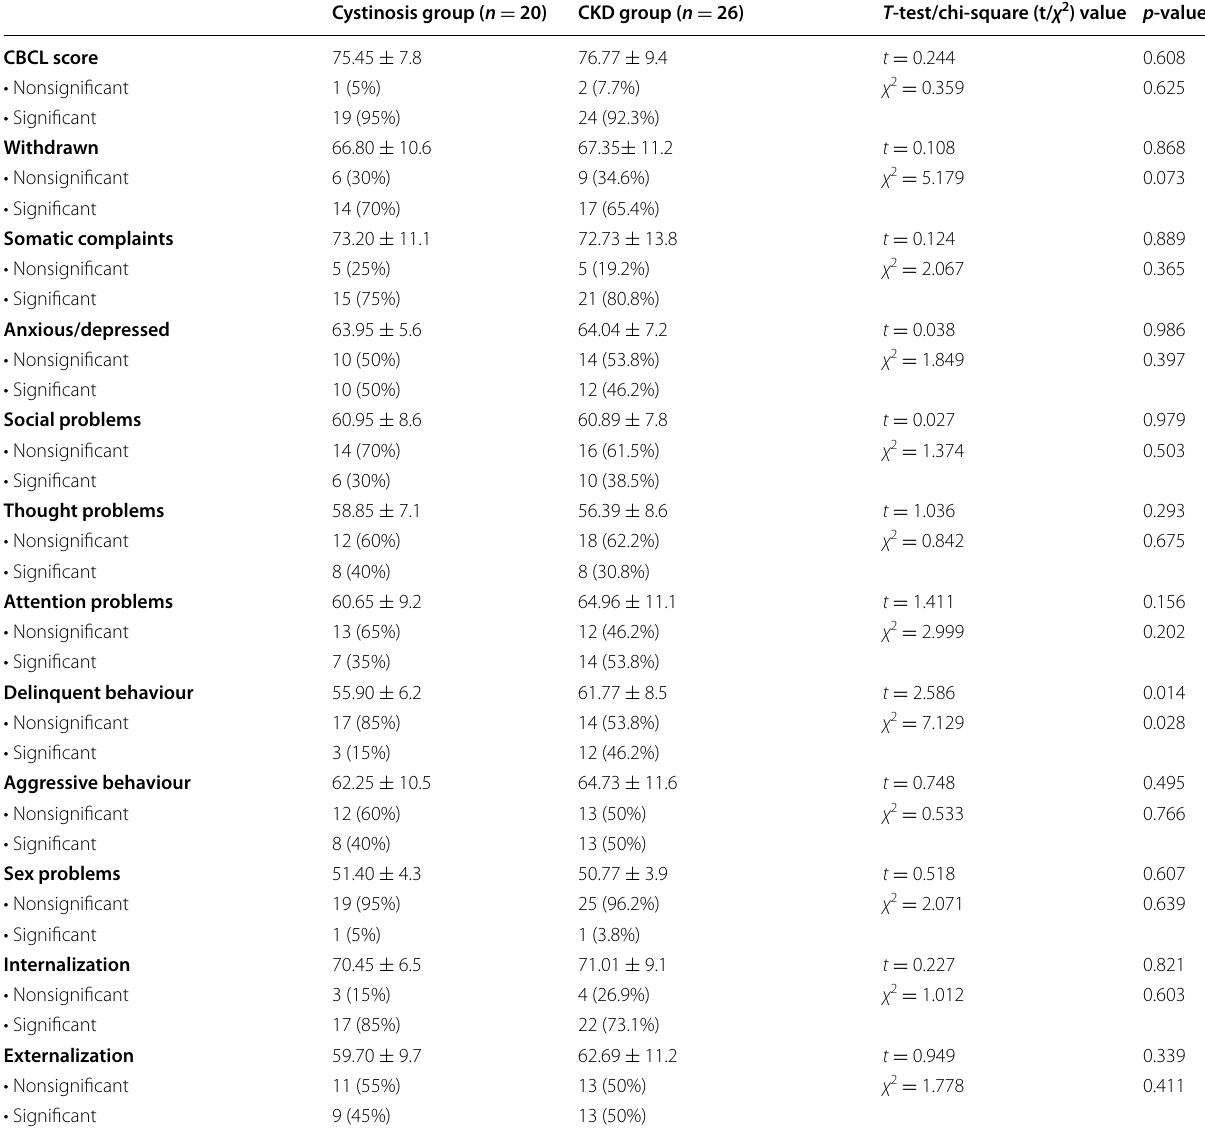
Table 4 Comparison between cystinosis and CKD groups regarding Child Behaviour Checklist (CBC)